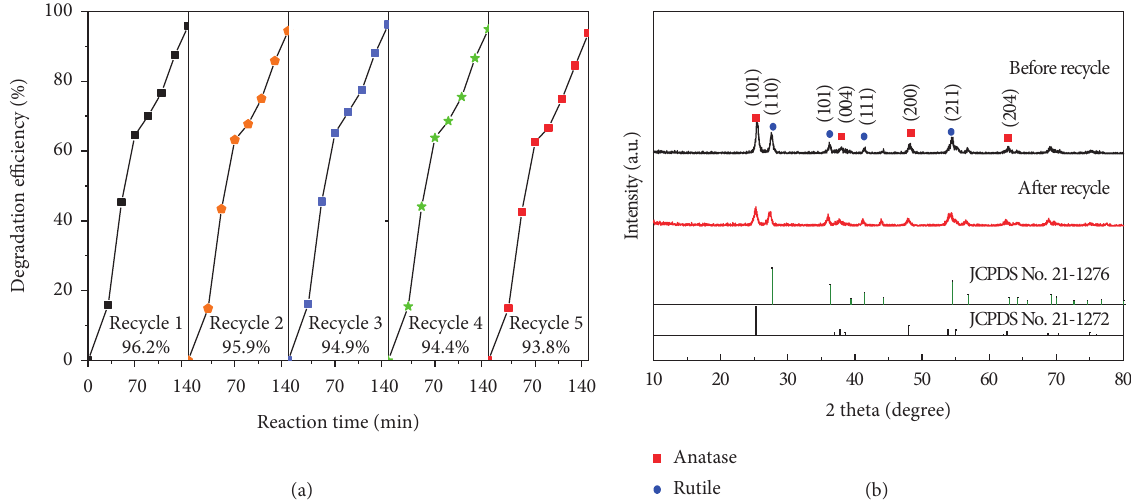
Figure 3: (a) Photodegradation performance within five cycles for 5% WO before and after